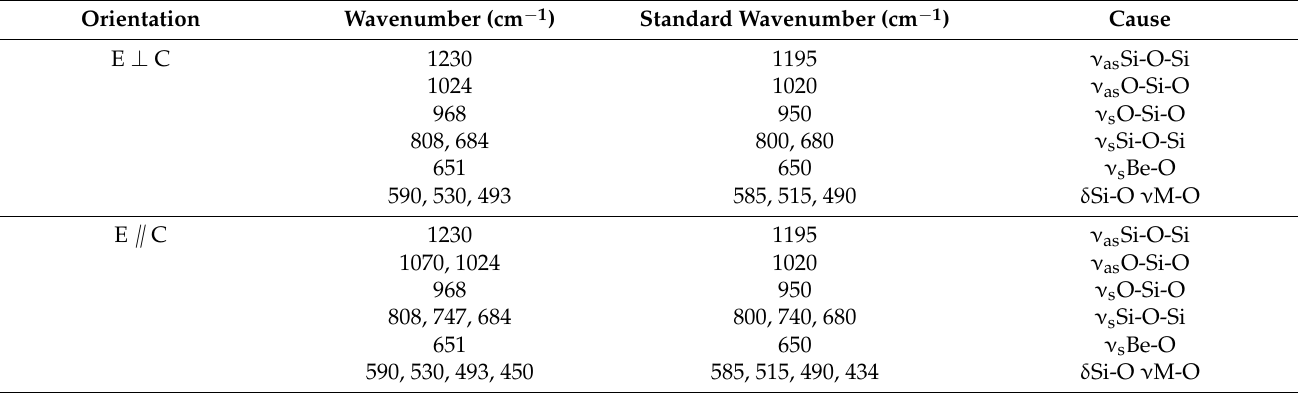
Figure 5. Absorption spectrum between 400 and 1300 cm − 1 of sample no.1–6 in two directions. Black spectrum was tested in the direction of E ⊥ C; red spectrum was tested in the direction of E ∥ C. The main vibration peaks from Figure 5 and their causes are given in Table 1 [17–20]. Table 1. Absorption bands in the region 400–1300 cm − 1 and their cause.